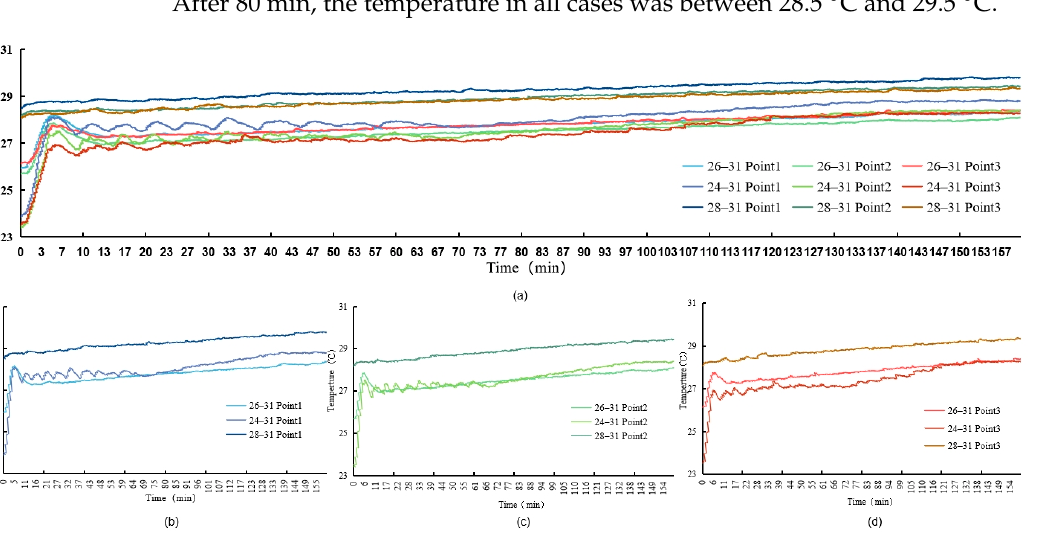
Figure 11. Temperature time series distributions at monitoring points under ventilated conditions. ( a ) Temperature distribution of three points in case7–9. ( b ) Temperature distribution of the point1 in case7–9. ( c ) Temperature distribution of the point2 in case7–9. ( d ) Temperature distribution of the point3 in case7–9.